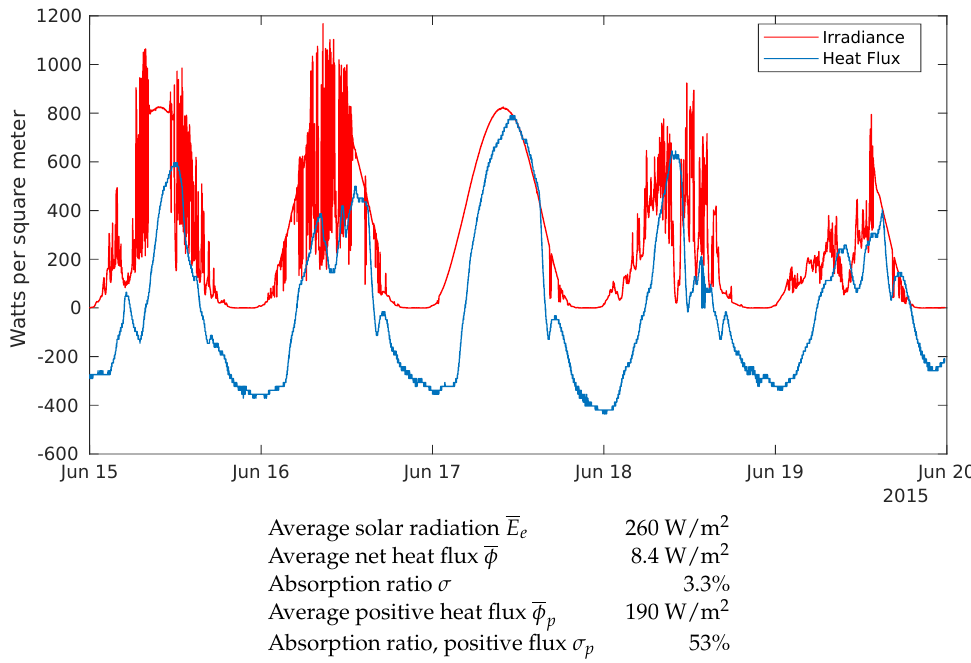
Figure 10. Instantaneous solar irradiation E e [W/m 2 ] and heat flux φ [W/m 2 ] from 15 to 20 Jun 2015 (summer) as a function of time (day) and their estimated average